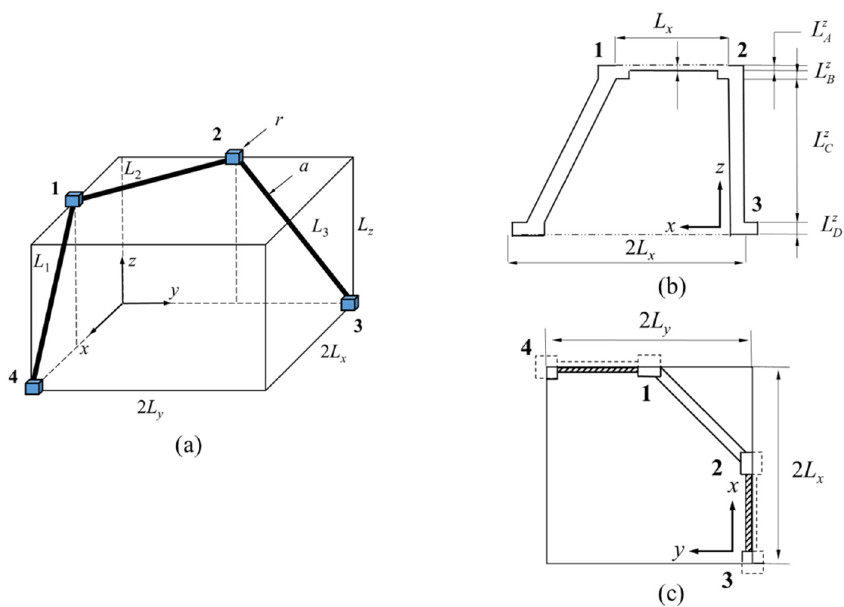
Figure 2. Schematic diagram of the hexahedral unit cell; ( a ) 3D schematic and the dimensions; ( b ) The view of y direction for hexahedral unit cell; ( c ) The view of z direction for hexahedral unit